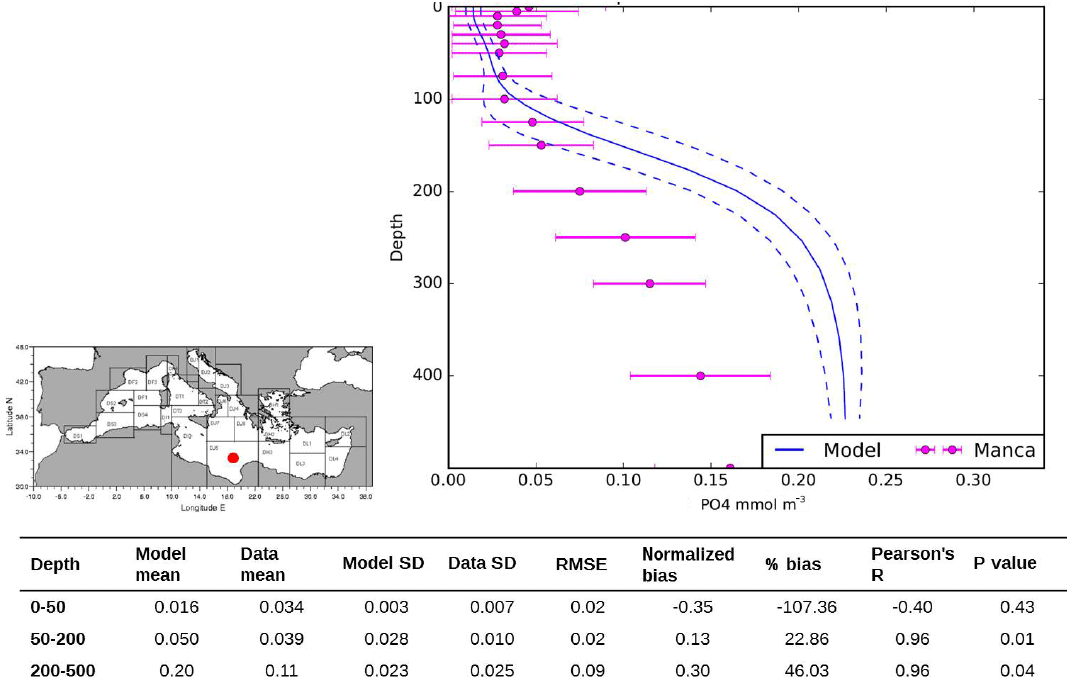
Figure A3. Annually averaged PO 4 vertical profile in the south Ionian sub-basin (see map and Manca et al., 2004) and statistical indicators over different depths. Model values are shown with the blue line (2005 average, Ntot simulation from Richon et al., 2017) and measured values from Manca et al. (2004) are in pink. Horizontal bars and dashed lines indicate the spatial SD of observations and model results respectively.